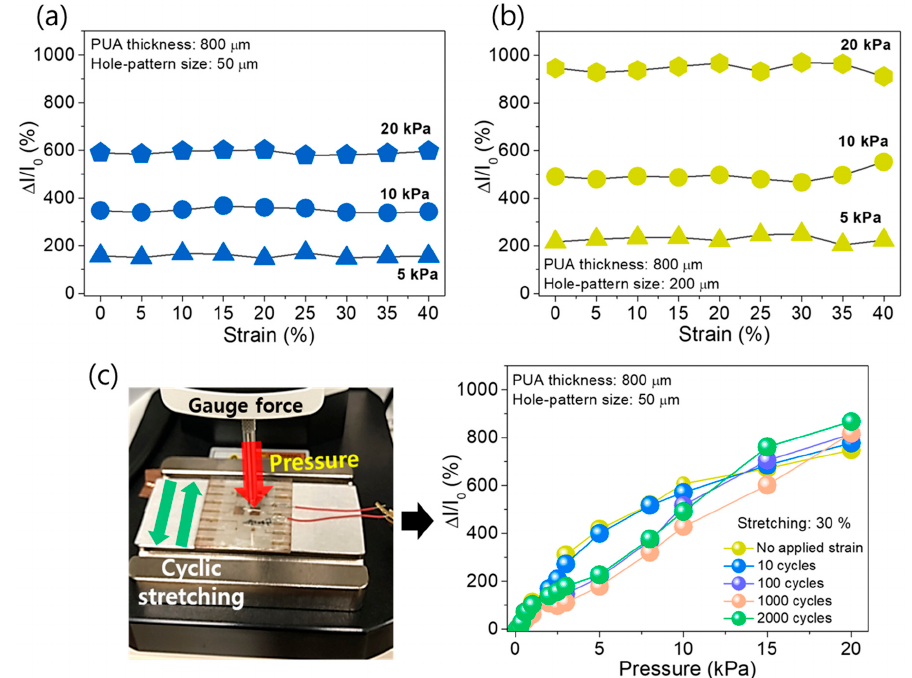
Figure 4. The strain durability response test of pressure sensors. The static responses of ( a ) D-50 and ( b ) D-200 pressure sensors in stretched state from 0% to 40%. The sensors pressed on 20, 10, and 5 kPa on customized stretching jig, respectively. ( c ) The picture of pressure measurement in gauge force ( left ) and a relative current change of pressure sensor after cyclic stretching test from without strain to the after 2000 cycles of 30% strain ( right ).